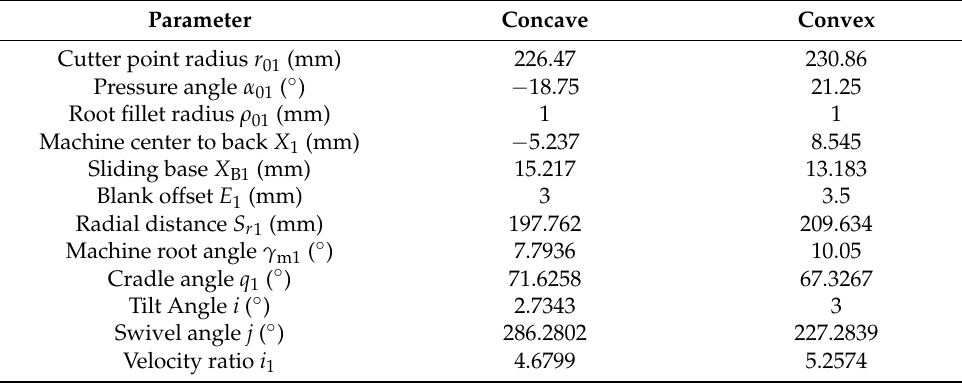
Table 2. Machine tool settings of bevel